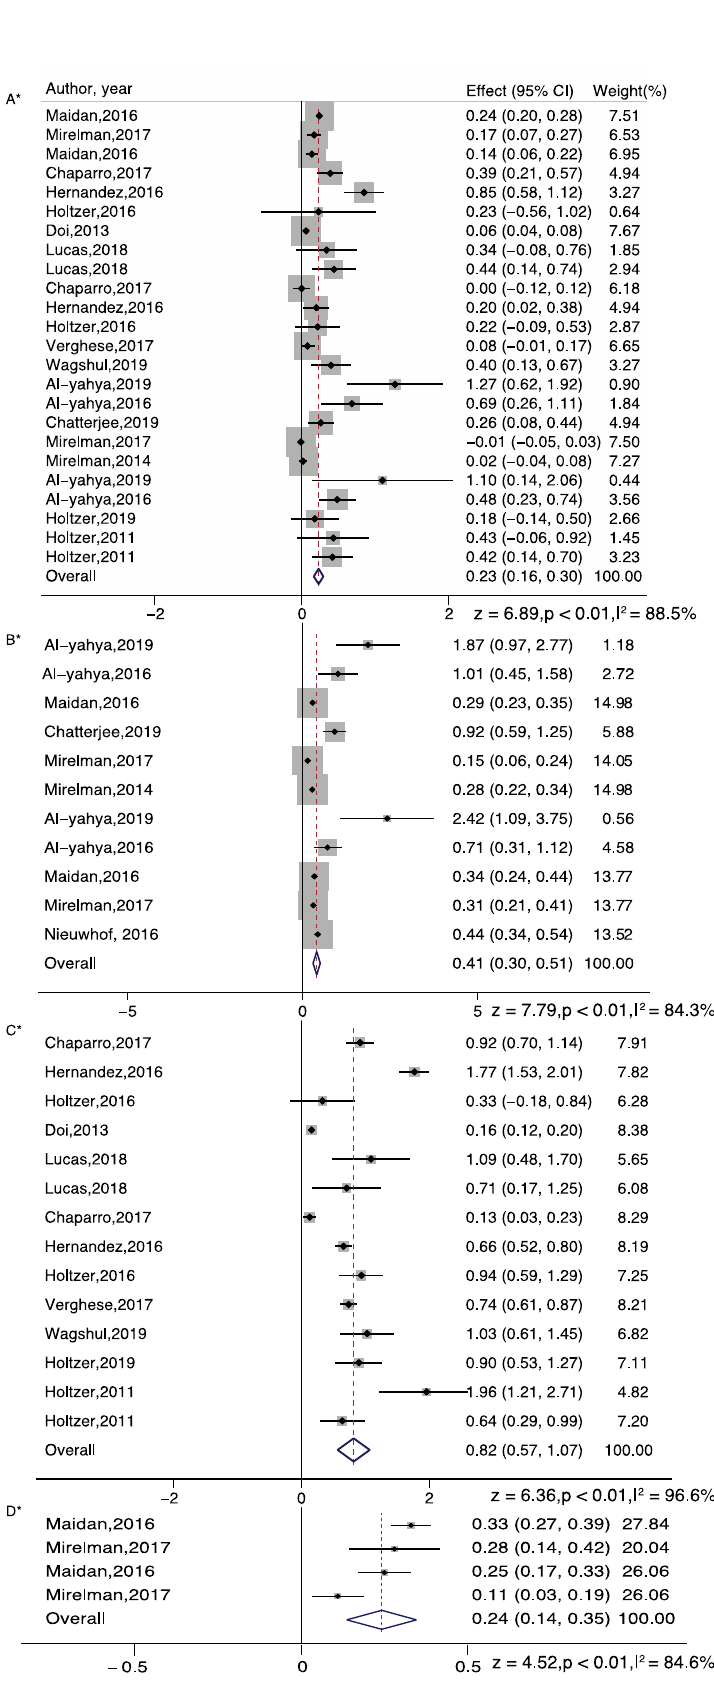
Figure 2. Brain activation differences while doing single task walking ( A ), serial subtraction task ( B ), letter generation task ( C ), or obstacle walking task ( D ). Note: * represents Random plot meta- analysis.